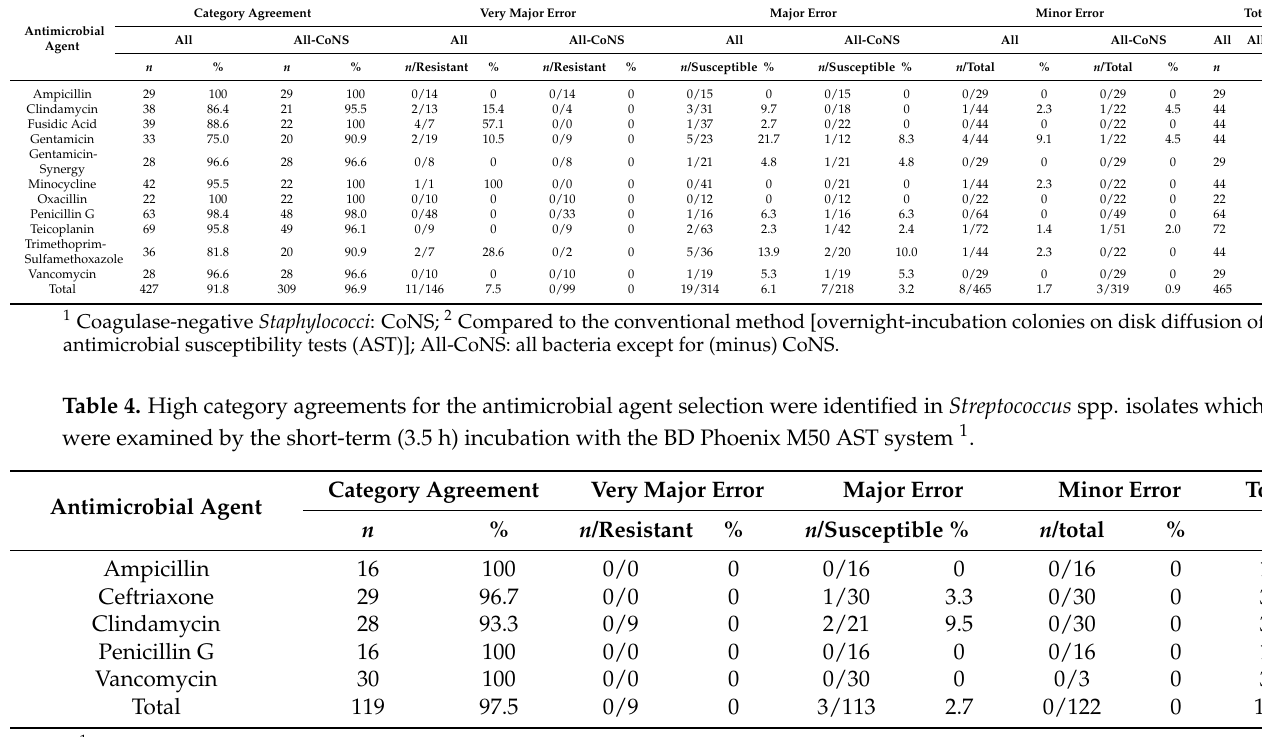
Table 3. Except for CoNS 1 , high category agreements for the antimicrobial agent selection were identified in Gram-positive bacteria which were examined by the short-term (4.5 h) incubation with the BD Phoenix M50 AST system 2 . Antimicrobial Agent